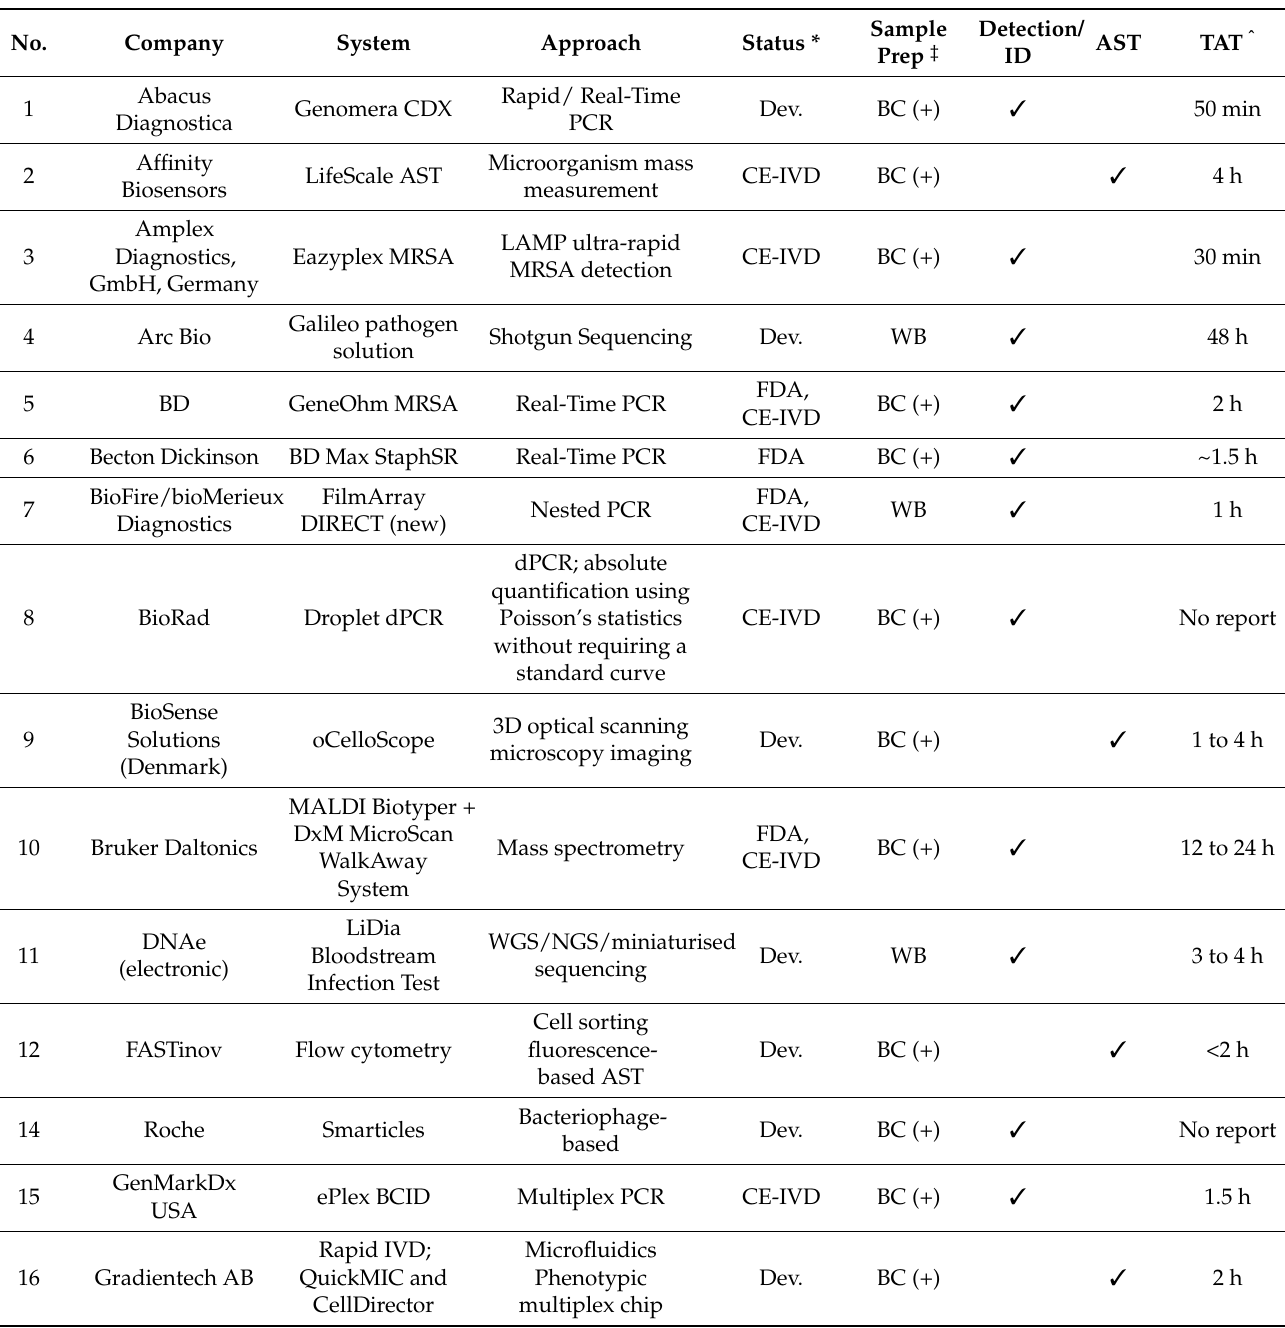
Table 1. List of commercial and developing technologies for BSI